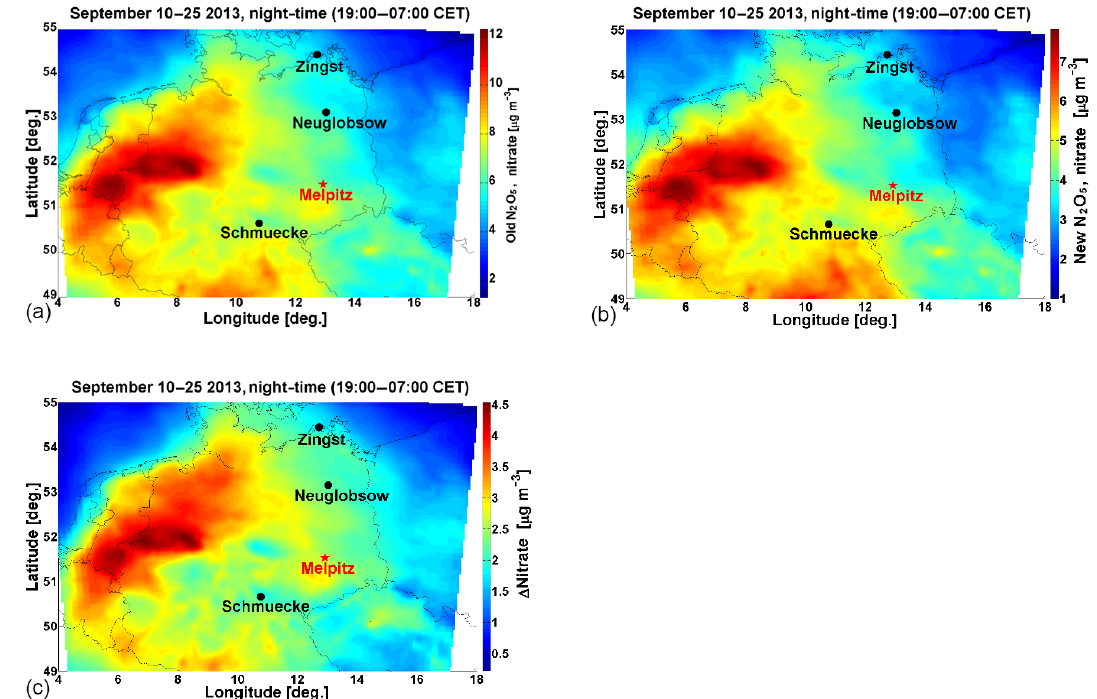
Figure 5. Horizontal distribution of averaged modelled particulate nitrate mass concentration during night-time on 10–25 Septem- ber. (a) OldN2O5 case; (b) NewN2O5 case; (c) difference between OldN2O5 and NewN2O5